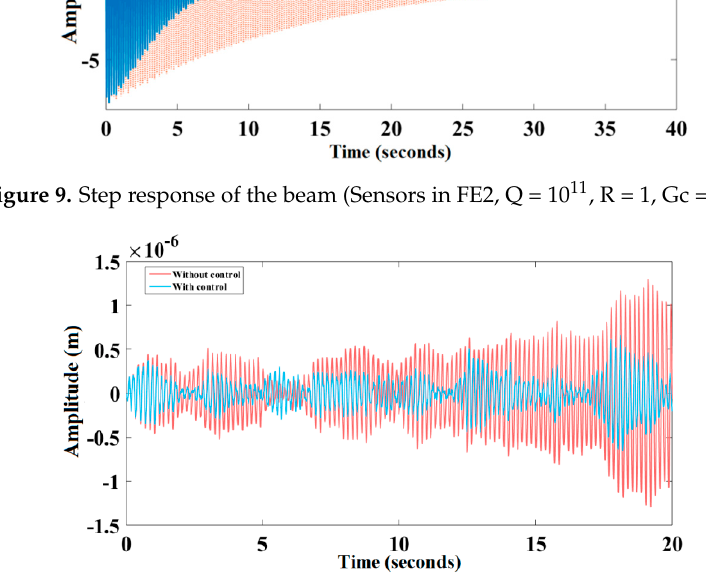
Figure 10. White noise response (Sensors in FE2, Q = 10 12 , R = 1, Gc = 100).